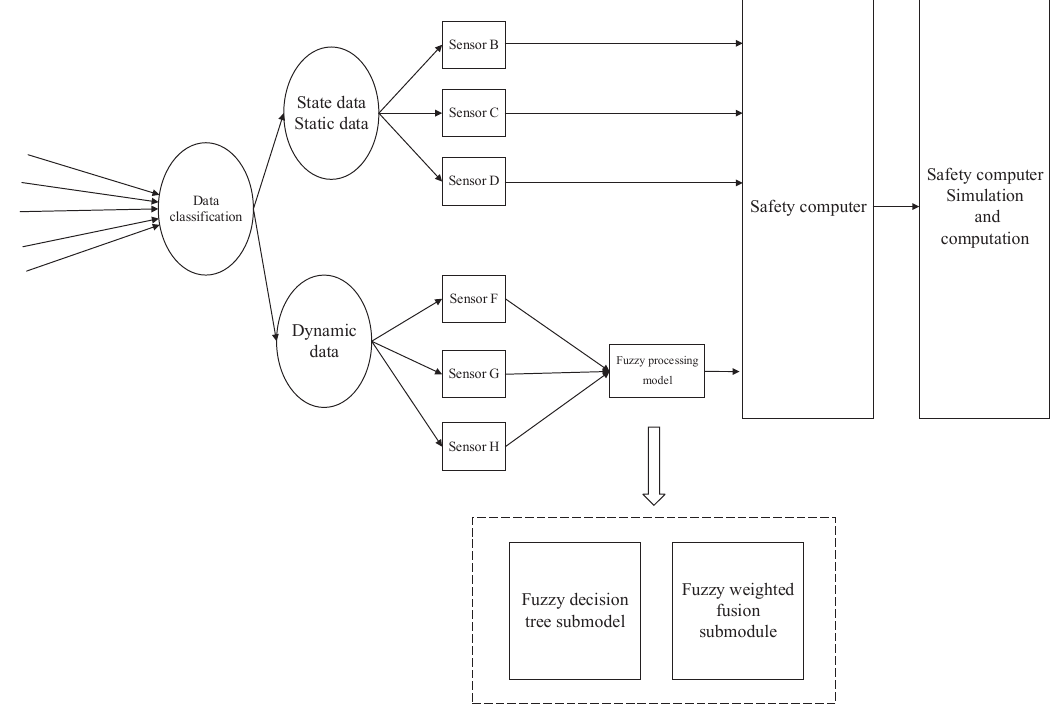
Figure 2. The architecture of the improved onboard safety computer